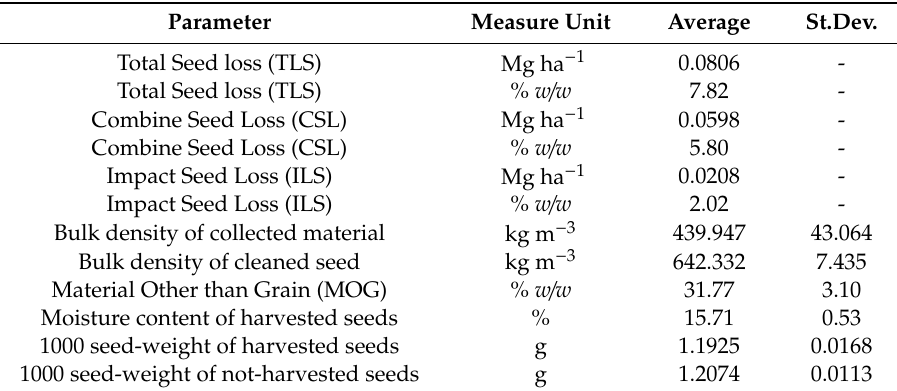
Table 6. Seed loss and MOG analysis. Weights are given in